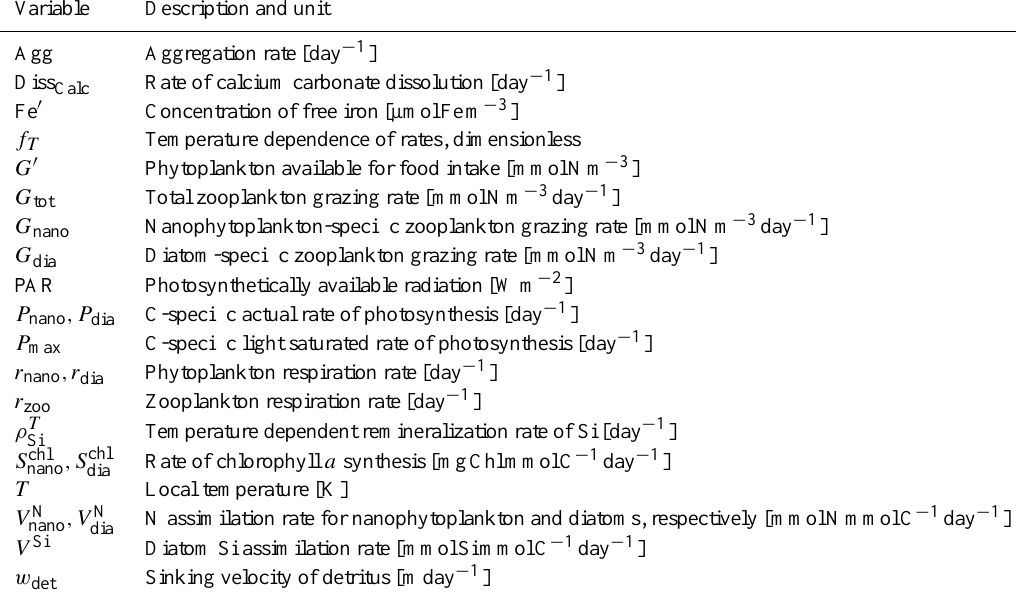
Table A4. Model variables.